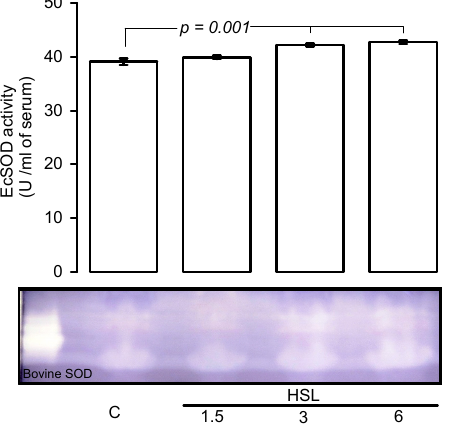
Figure 3. Native gel representative, HSL infusion at 3 and 6% increased the EcSOD activity in serum. In a native gel the TEMED and riboflavin in presence the UV light and oxygen of the medium; produce O 2– , the NBT and EcSOD compete for them, where EcSOD is present; the gel remains transparent, whereas reduced the NBT turns to purple-blue.